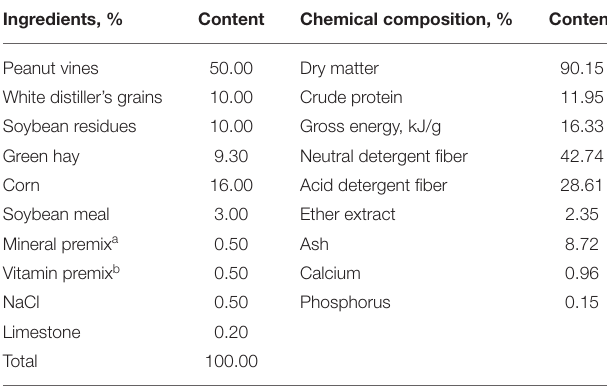
TABLE 1 | Ingredients and nutrient composition of experimental diets (DM